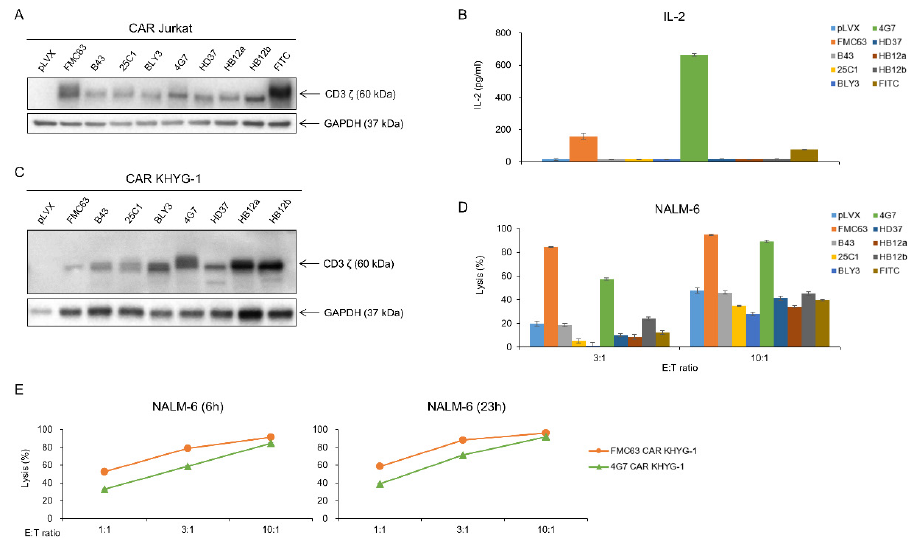
Figure 3. FMC63 and 4G7 CAR constructs effectively recognize antigen CD19. ( A ) After transfection of CD19 CAR genes into Jurkat cells, CAR expression was confirmed through the Western blot. ( B ) CD19 CAR Jurkat (2 × 10 5 cells) co-cultured with 2 × 10 4 NALM-6 cells for 21 h. IL-2 level secreted by CD19 CAR Jurkat was measured through ELISA assay. ( C ) After transduction of eight different CD19 CAR genes into KHYG-1 cells, CAR expression was confirmed through Western blot. ( D ) Tumor-killing ability of eight different CD19 CAR KHYG-1 cells against luciferase-expressing NALM-6. CD19 CAR KHYG-1 cells (E:T ratio 3:1 or 10:1) were co-cultured with luciferase-expressing NALM-6 (1.5 × 10 4 cells) for 7 h. Then, luminescence values were measured. ( E ) FMC63 CAR KHYG-1 or 4G7 CAR KHYG-1 cells were incubated with NALM-6 at different E:T ratios (1:1, 3:1, and 10:1) and different incubation times (6 h and 23 h) to see their lytic activity.